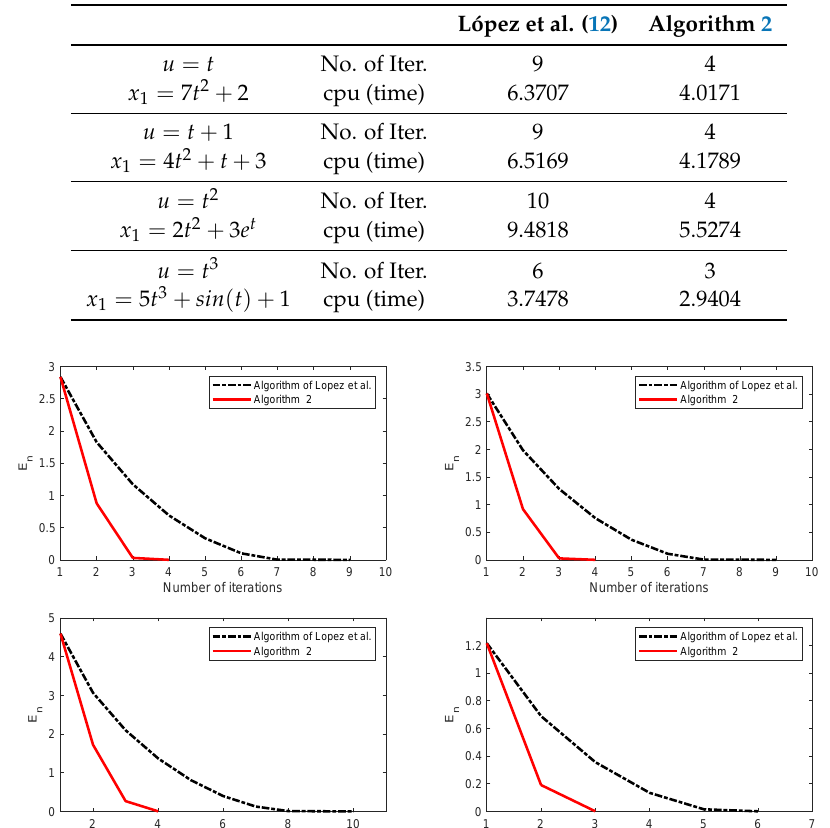
Table 3. Numberof iterations for Algorithm 2 in L 2 -space.